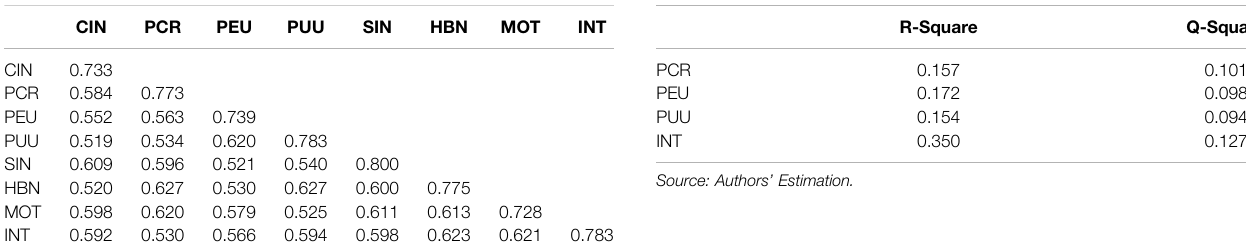
TABLE 5 | Discriminant validity Fornell – Larcker criterion.